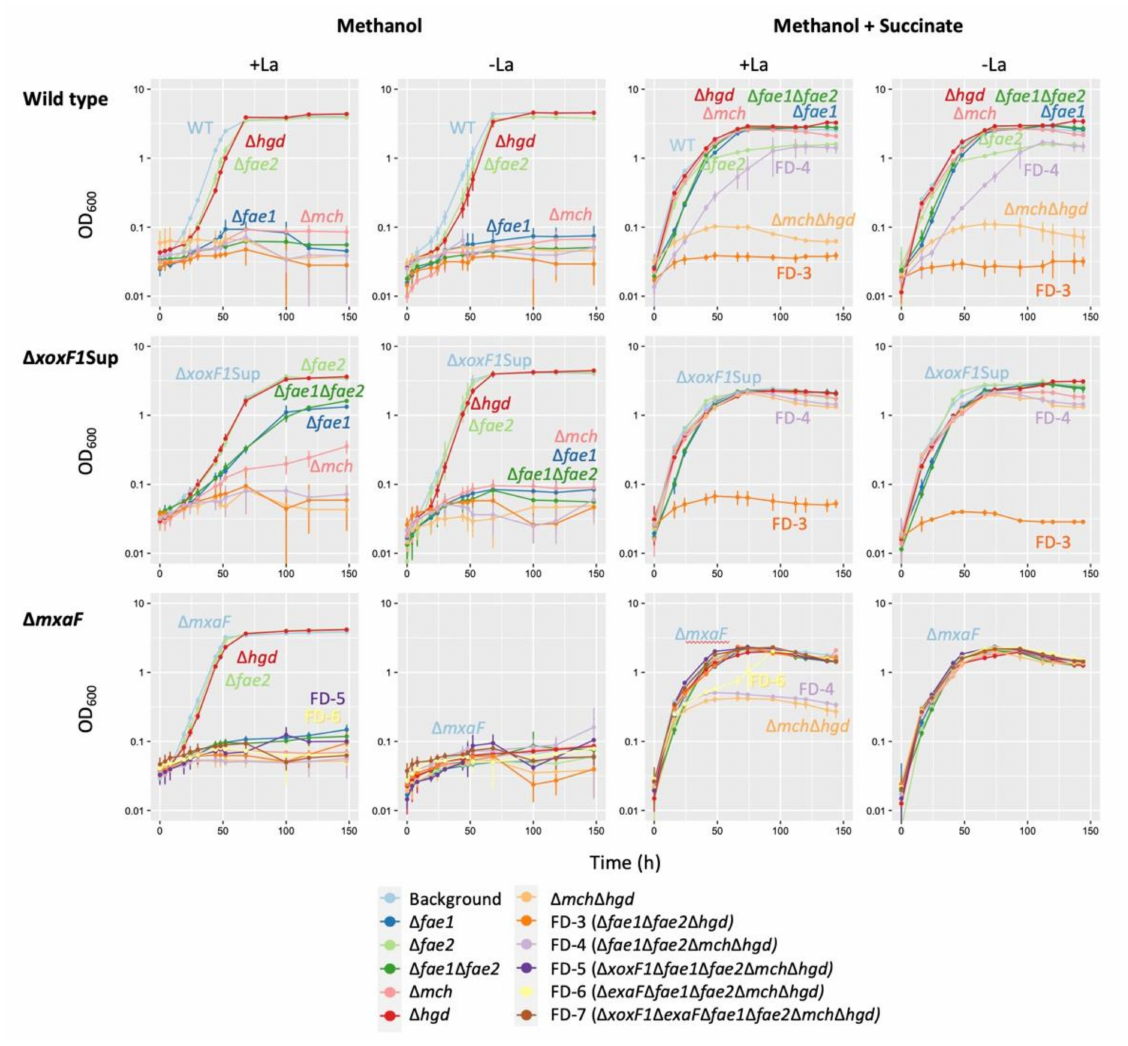
Figure 7. Growth of various formaldehyde oxidation-pathway mutants constructed in the wild-type, ∆ xoxF1 Sup, and ∆ mxaF backgrounds, in methanol and methanol plus succinate liquid medium in the presence and absence of La 3 + . FD-3 ( ∆ fae1 ∆ fae2 ∆ hgd ), FD-4 ( ∆ fae1 ∆ fae2 ∆ mch ∆ hgd ), FD-5 ( ∆ xoxF1 ∆ fae1 ∆ fae2 ∆ mch ∆ hgd ), FD-6 ( ∆ exaF ∆ fae1 ∆ fae2 ∆ mch ∆ hgd ), and FD-7 ( ∆ xoxF1 ∆ exaF ∆ fae1 ∆ fae2 ∆ mch ∆ hgd ) correspond to all three genetic backgrounds, except that FD-5 to FD-7 were constructed only for the mxaF background. The results are presented as the average ± SD (technical